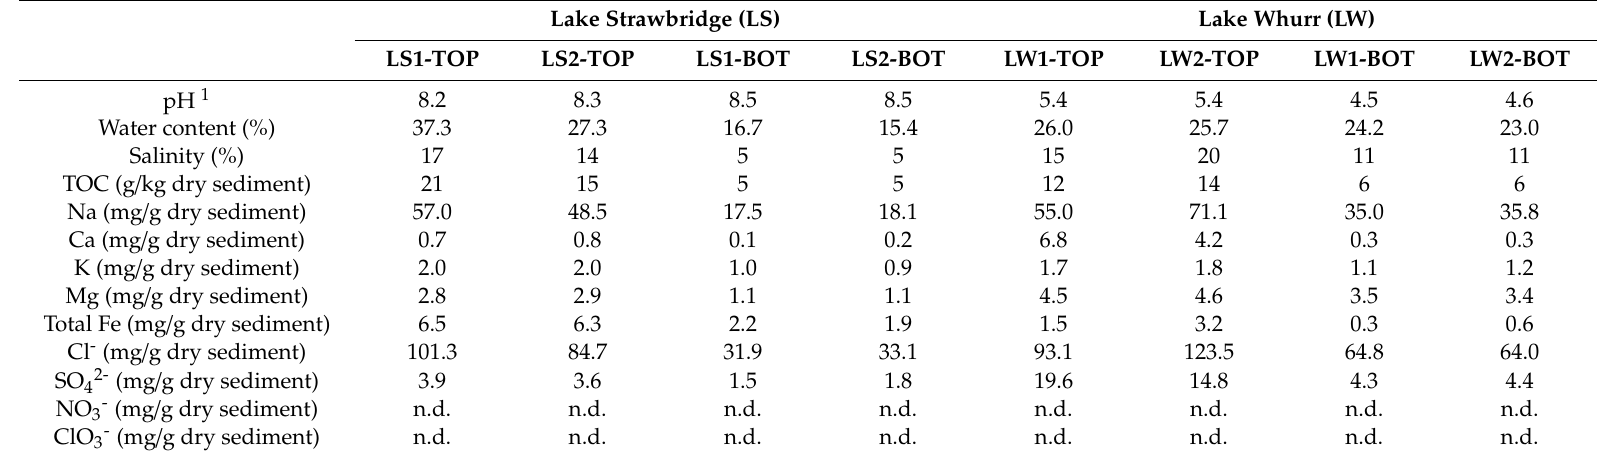
Table 1. Geochemical properties of Lake Strawbridge and Lake Whurr sediments. Duplicate sediment cores from each hypersaline lake are labelled as LS1&LS2 and